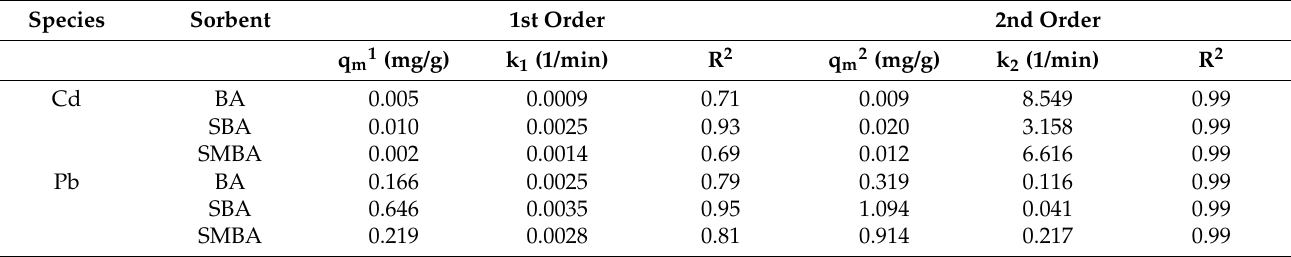
Table 2. Sorption kinetic model